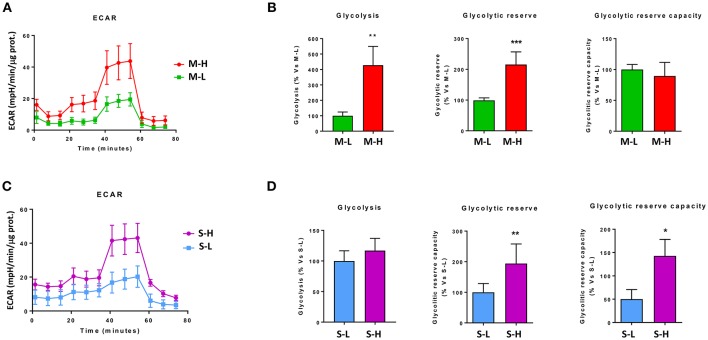
e-CSCs have elevated levels of aerobic glycolysis. The extracellular acidification rate (ECAR) was measured, using the Seahorse XFe96 metabolic-flux analyzer. Note that high ECAR in MCF7 cells directly correlates with high-flavin content. For example, M-H cells (from 2D-monolayers) and S-H cells (from 3D-spheroids) have the highest levels of ECAR, as compared to the M-L and S-L sub-populations. (A,B) ECAR for M-L vs. M-H sub-populations; (C,D) ECAR for S-L vs. S-H sub-populations. *p < 0.01, **p < 0.001 and ***p < 0.0001.